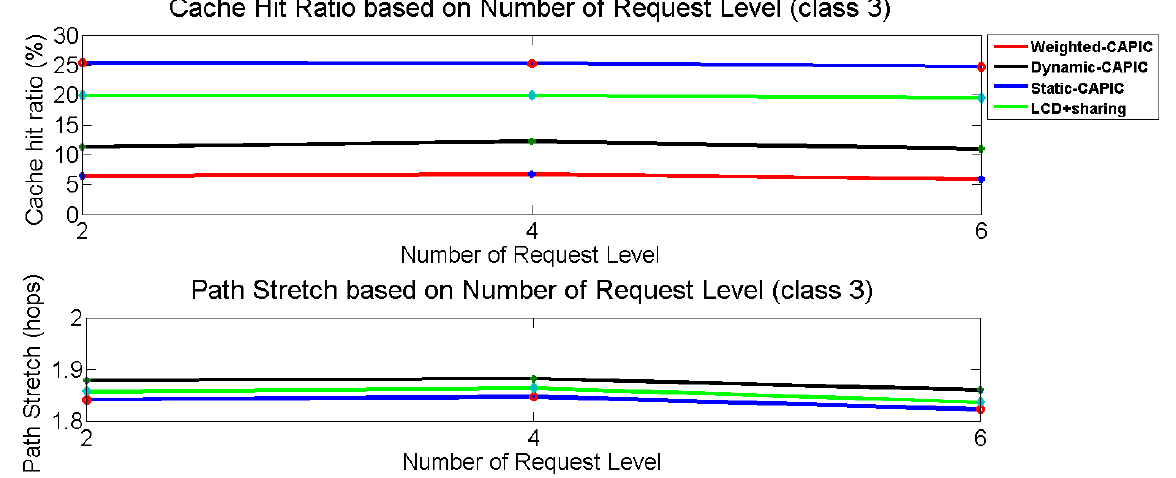
Figure 4. Cache hit ratio and path stretch of class 3 for various level of